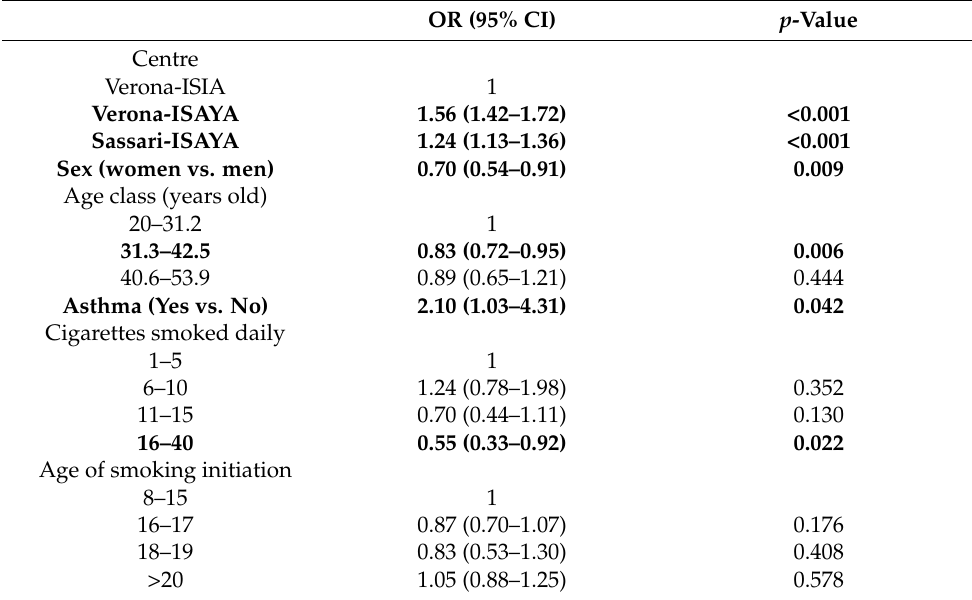
Table 3. Influence of socio-demographic characteristics, respiratory disorders, smoking intensity, and age at smoking initiation on smoking